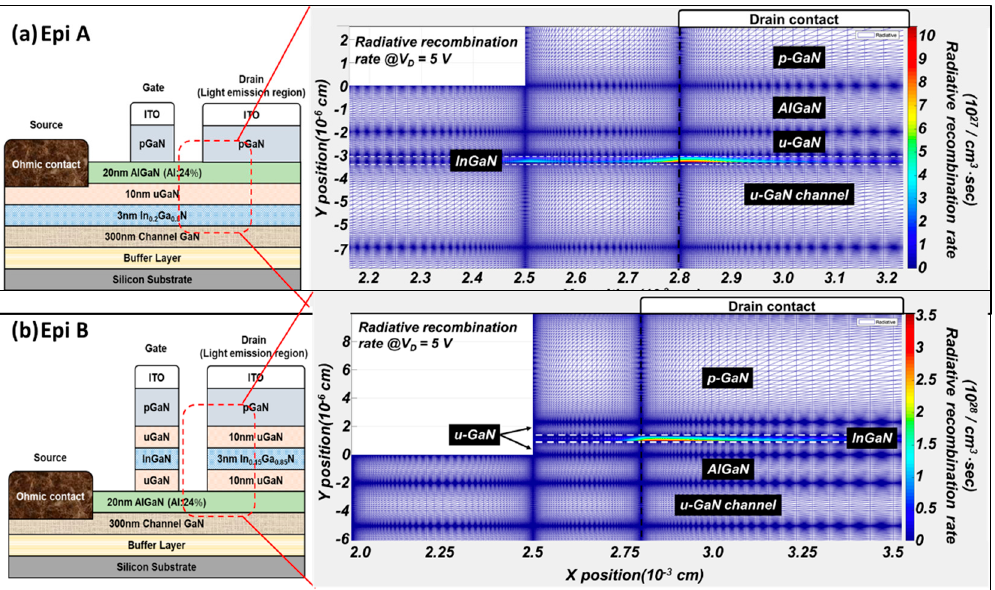
Figure 2. Simulation of radiative recombination rate in the light-emitting region of LE-HEMT on ( a ) Epi A and ( b ) Epi B structures .